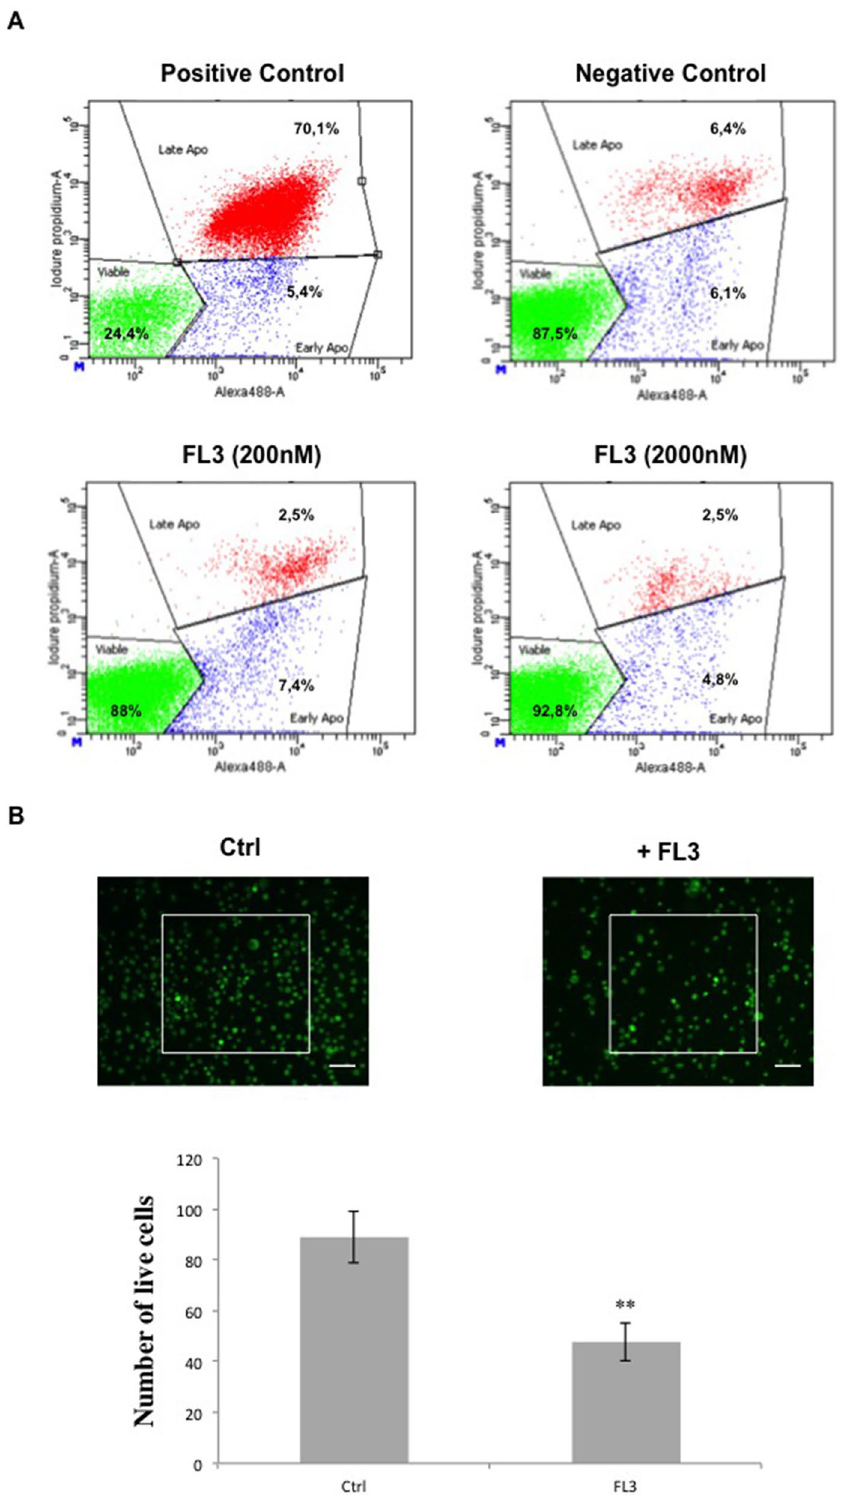
Figure 2. Analysis of the apoptosis in glioblastoma cancer cells. ( A ) Flow cytometry analysis of Annexin V and PI staining in U87-MG cells treated with 200 and 2000 nM FL3 and compared to positive and negative controls. We used an NF-κB inhibitor as positive control. Results are obtained from 3 independent experiments. ( B ) Live/dead assay on U87-MG cells treated or not with 200 nM FL3 and quantification of live cells in each condition. The scale bar represents 20 μm. Cells within white boxes were counted at each time. Quantification of mean ± SEM from 3 independent experiments, **P < 0.01 from control. n = 3 for each